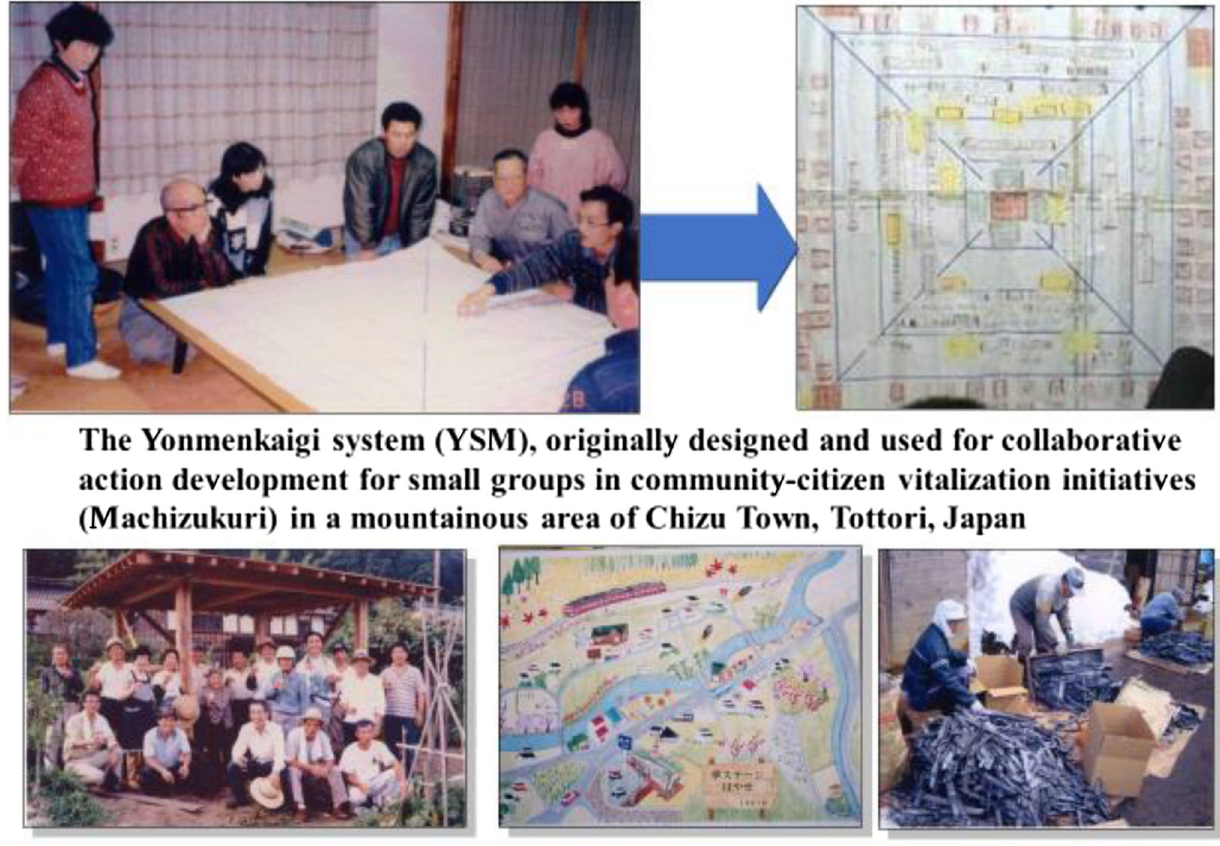
Fig. 6 Chizu Town’s challenges to build a common platform with the use of the Yonmenkaigi System Method (YSM)—Hayase village community, Zero-to-One Stage 1. (The upper-left photo shows the scene of community people participating in a workshop by use of the Yonmenkaigi System Method (YSM). The YSM chart-based com- munity plan developed by the people is shown in the upper-right photo. After building up together a small community rest area, the community people posed for the lower-left photo. The lower-middle